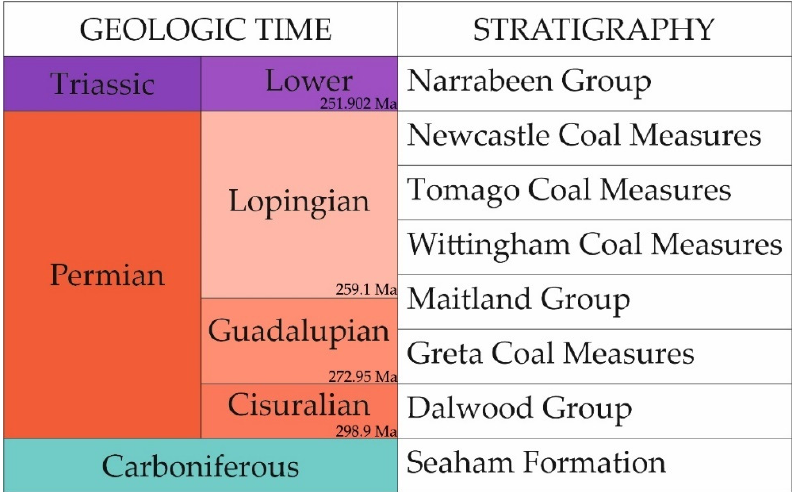
Figure 2. Carboniferous to Permian stratigraphic column of the Northern Sydney Basin (modified from [40,41]).